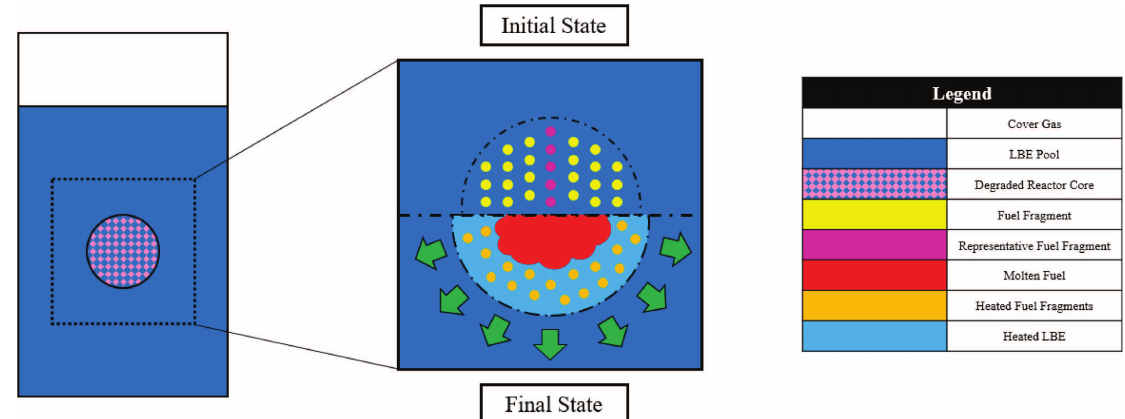
Fig. 1. Simplified overview of the reactor pool and the computational domain. The upper section of the computational domain represents the state of the core at the beginning of the transient, whereas the lower section represents the state of the core at the end of the